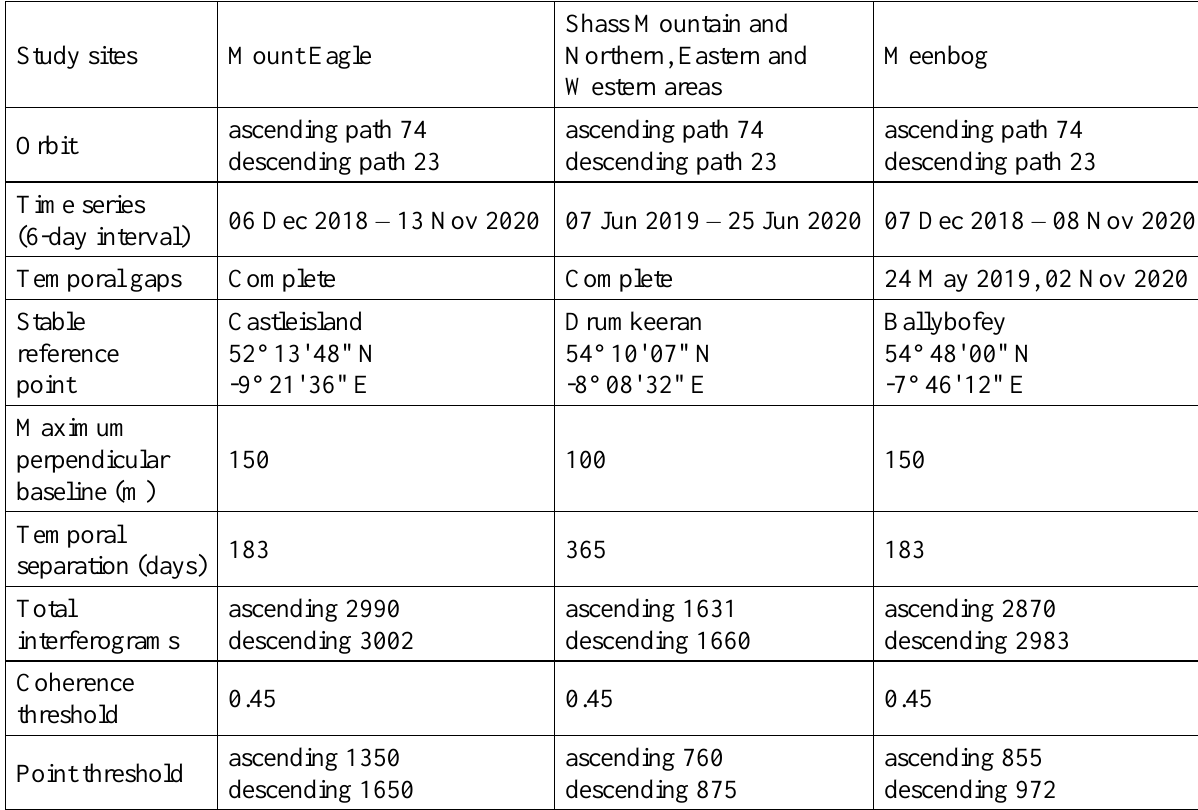
Table 2. Details of the Sentinel-1 radar images and APSIS-InSAR processing parameters. Study